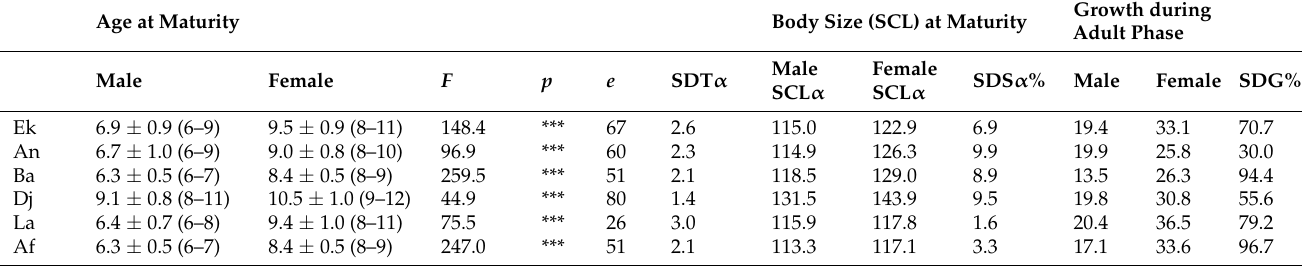
Table 4. Age and body size at maturity and growth during adulthood differed between the sexes of Algerian T. graeca . Here, the results for age (year) and body size (millimeter) are taken as means, and those in parenthesis are ranges. F and p values are from a one-way ANOVA ( e , error degrees of freedom; Sample size ( n ) = e + 2. *** = p < 0.001; SDT α , Sexual difference in time of maturity is calculated here as (Female age at maturity − Male age at maturity); SCL α , straight carapace length at maturity; SDS α %, sexual size dimorphism at maturity is calculated as 100 ((Female SCL α − Male SCL α )/Male SCL α ); SDG%, sexual difference in growth to adulthood after maturity is calculated as 100 ((Female growth − Male growth)/Male